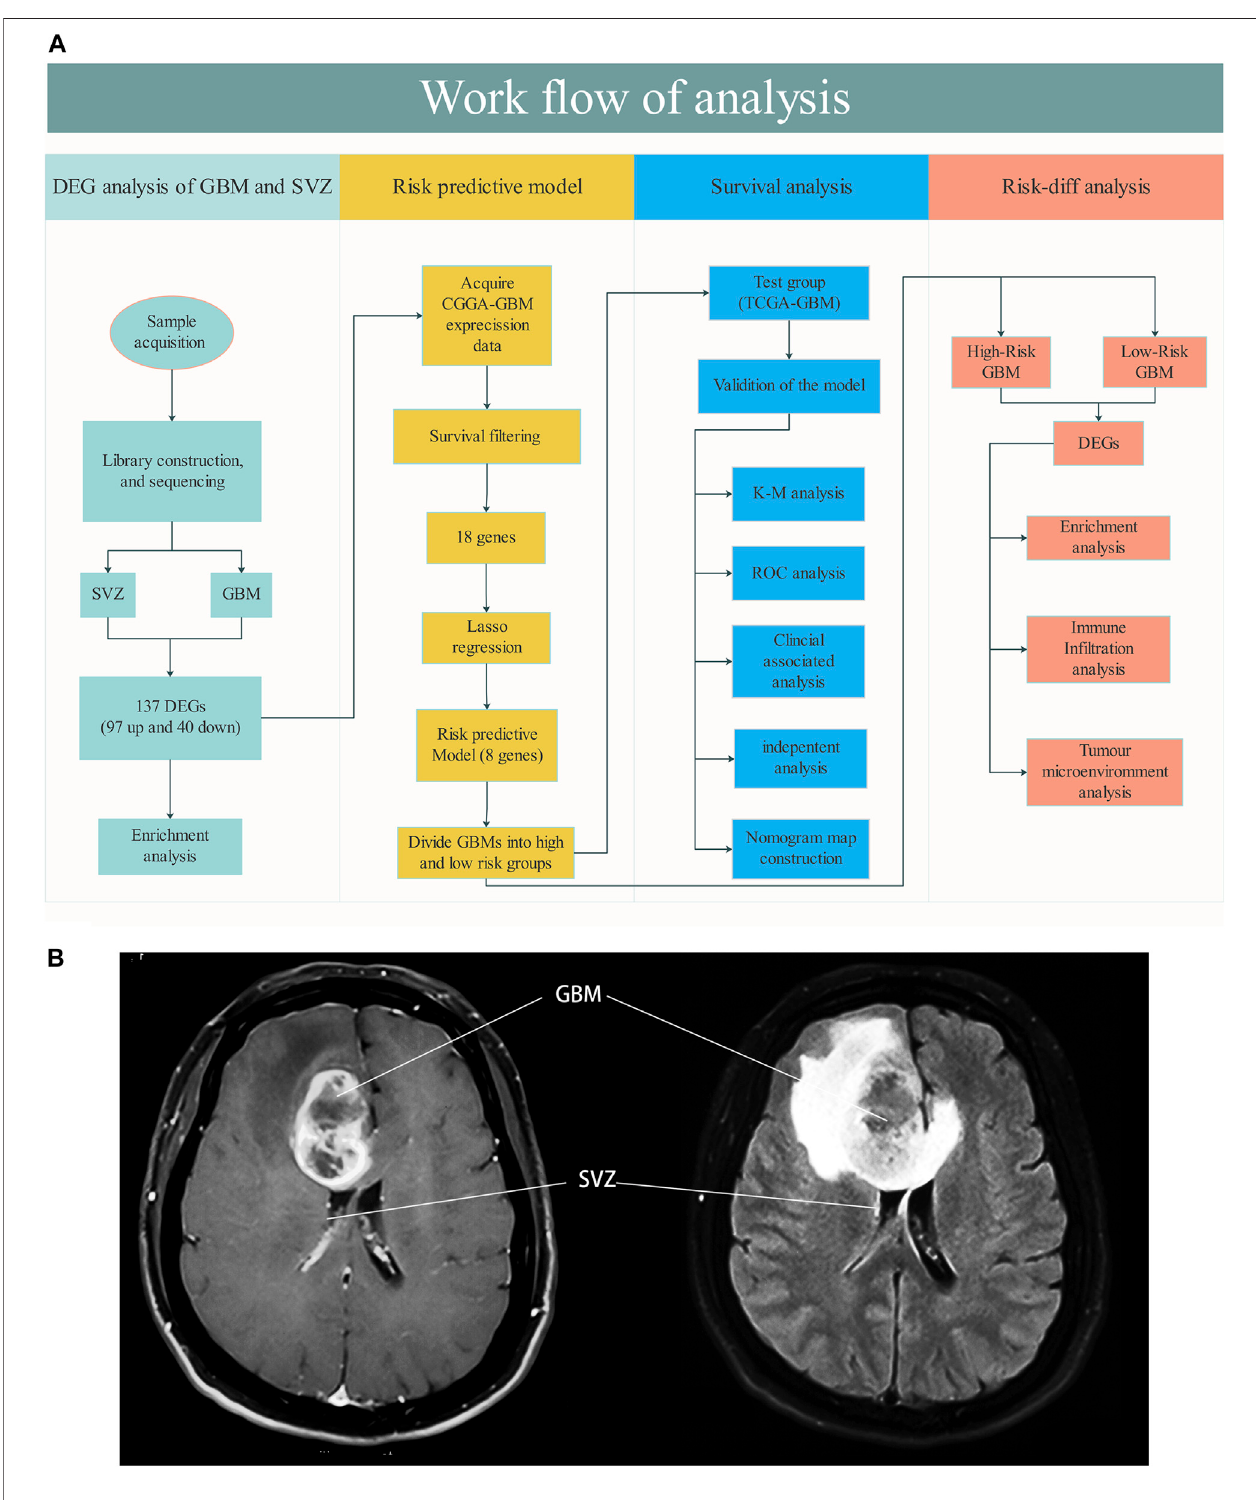
FIGURE 1 | (A) Work fl ow of the analysis. (B) Schematic diagram about SVZ involved GBM (MRI T1 Flair).